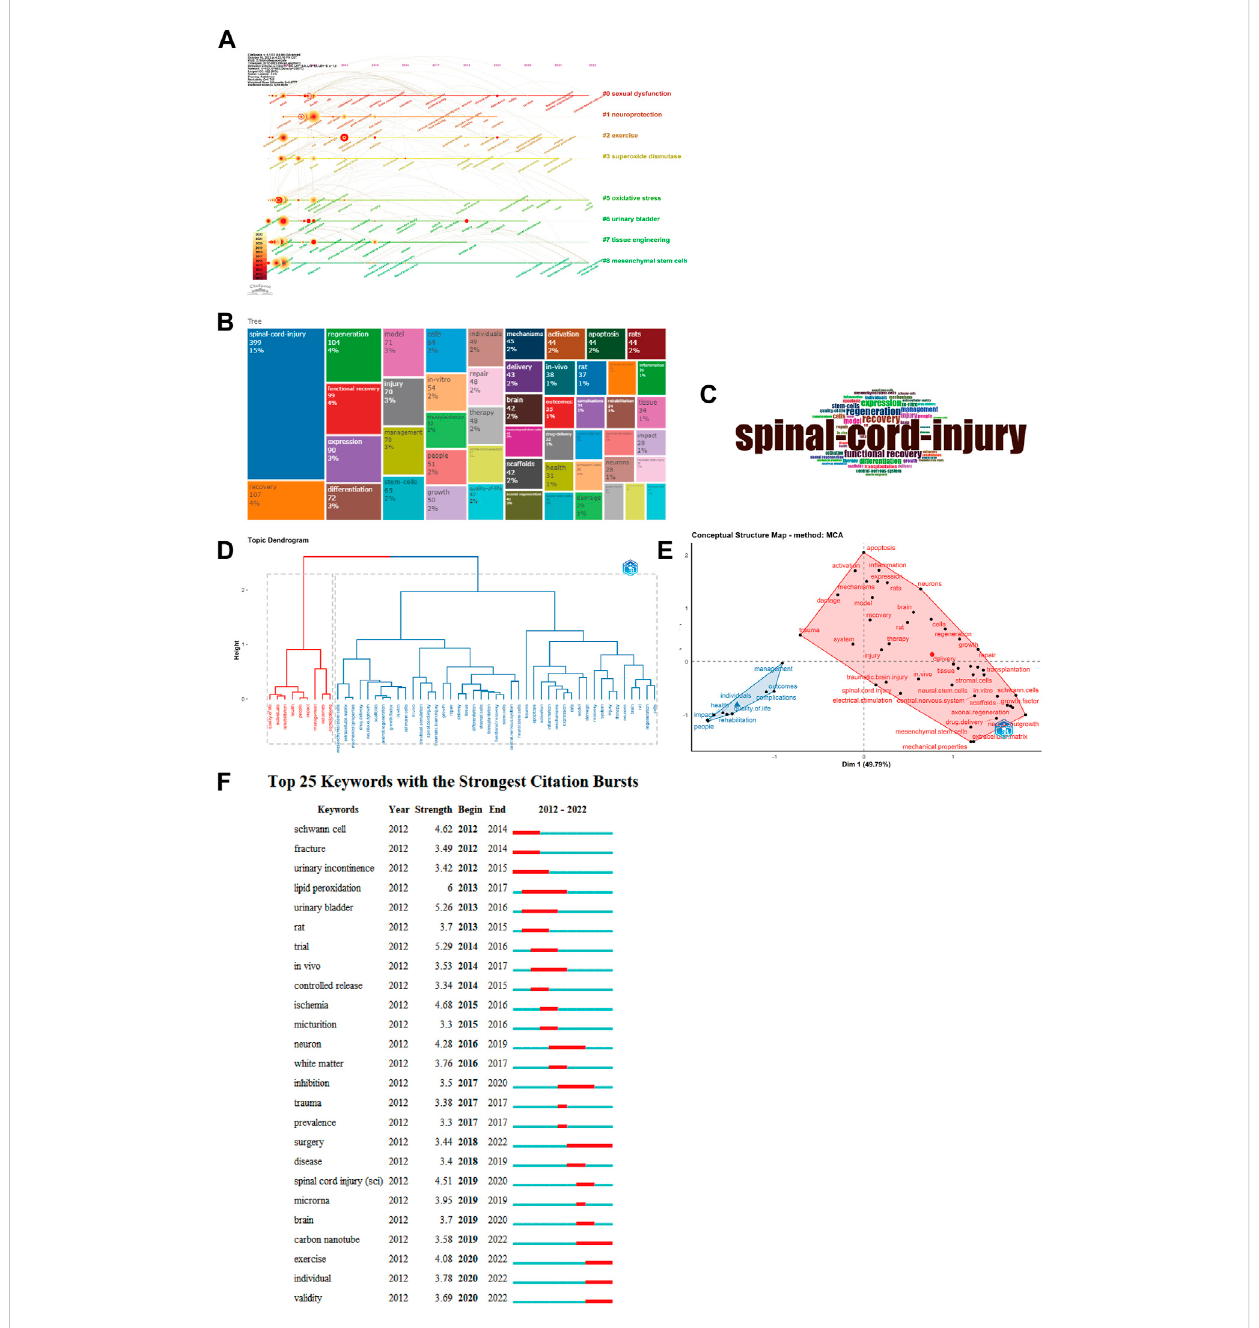
Representative burst keywords among top 25 keywords with the strongest citation